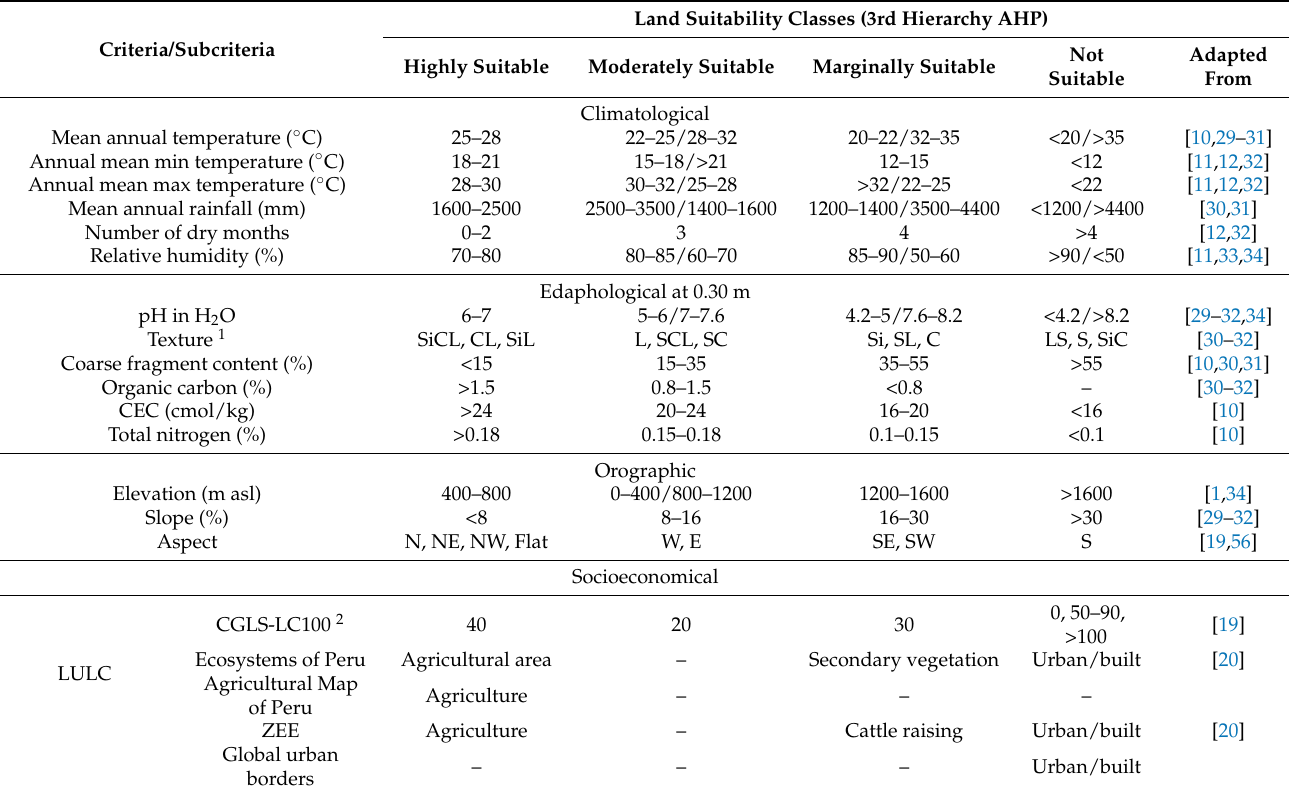
Table 2. Suitability thresholds of key criteria for cocoa cultivation in Peru, AHP model.